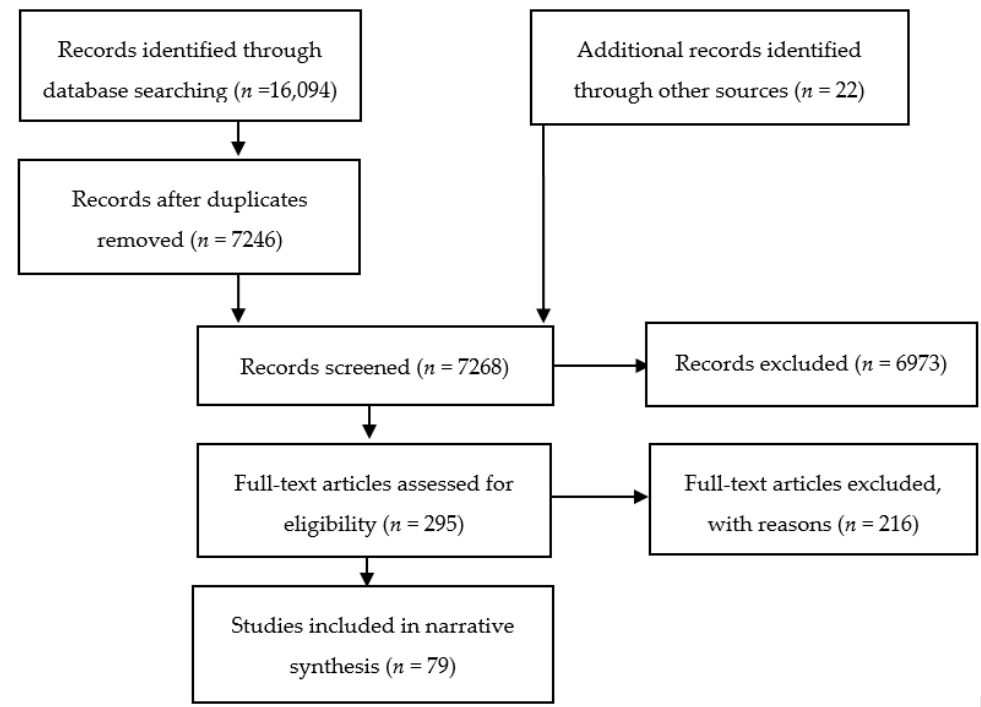
Figure 1. PRISMA flow diagram.